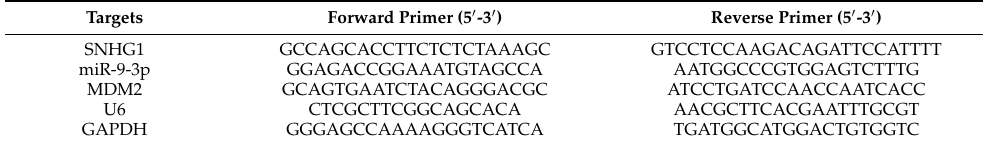
Table 2. Primer sequences for qRT-PCR.